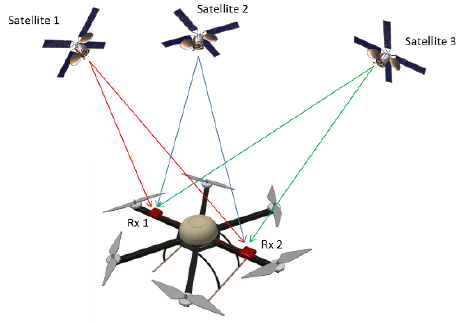
Figure 5: Short baseline antennas installed on the UAV to estimate the orientation